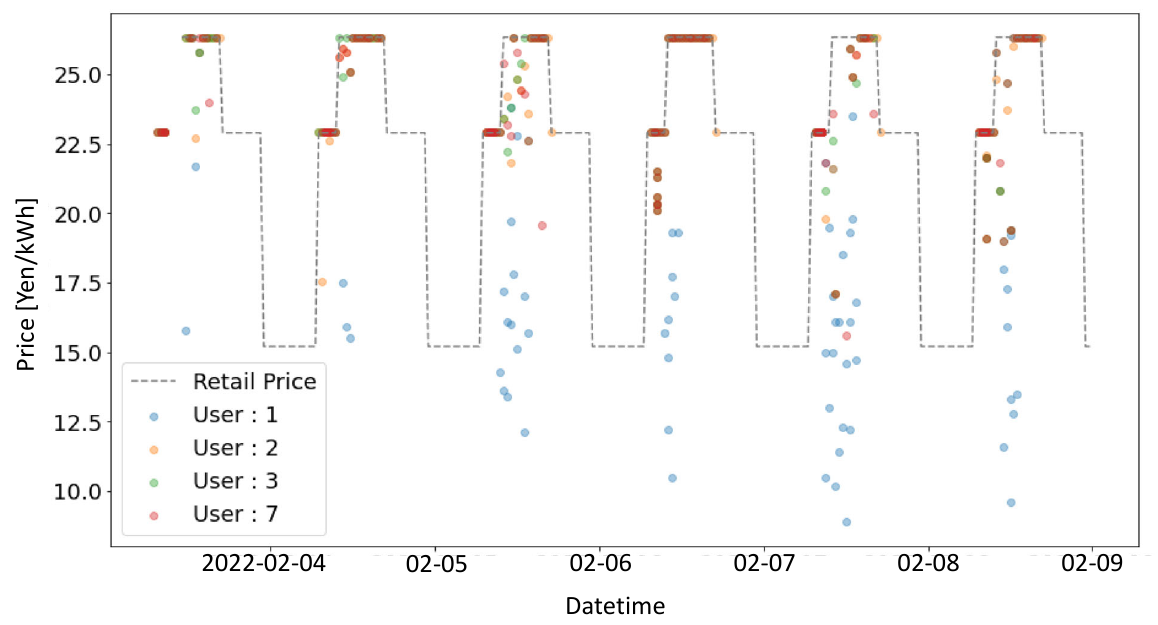
Figure 5. Trends in contract prices for all users in Phase 2 of the experiment.